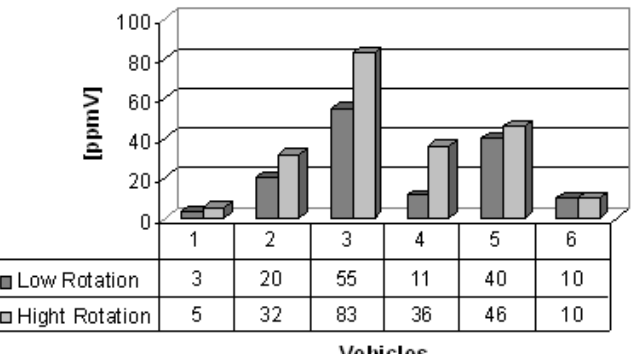
Figure 7. Sulfur dioxide gas concentration [ppmV].